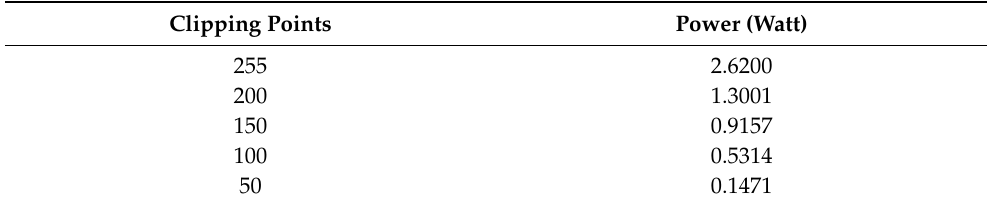
Table 1. The example of the clipping points and the corresponding power consumption (computed by Equation (19)).